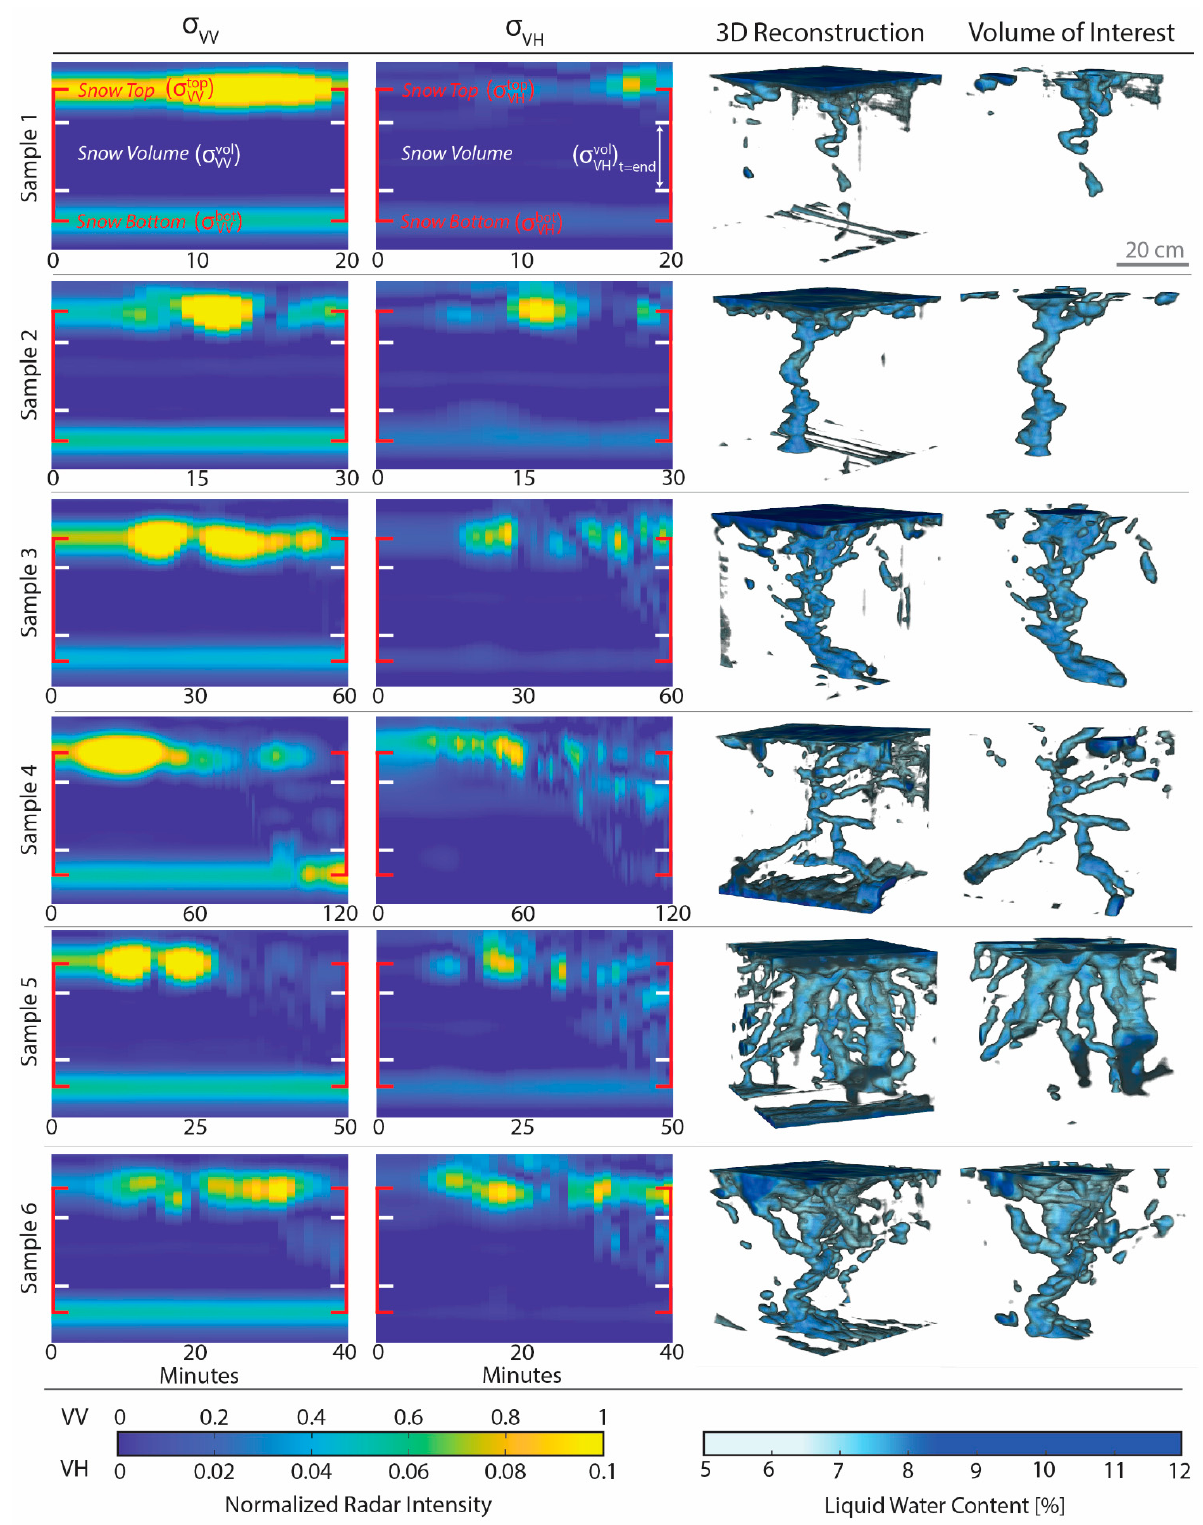
Figure 6. The first two columns are the continuous co-polarized and cross-polarized radargram for each melt experiment (Samples 1–6). The snow sample top and bottom are indicated with the red tick marks and the snow sample volume is represented as the area between the white tick marks. For visualization, the color scale for σ VV is an order of magnitude greater than σ VH . The second two columns are the corresponding 3D reconstruction and volume of interest with the liquid water content threshold set to 5%. Shading was applied to the 3D models to help visualize the structure.